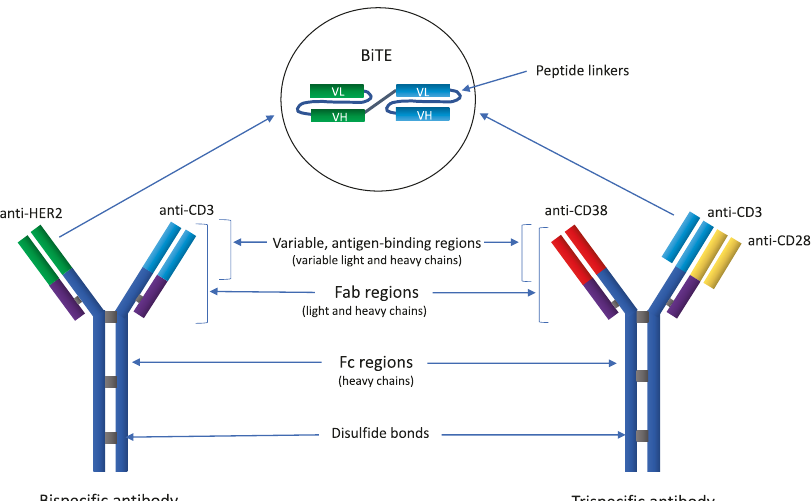
Fig. 5 Schematic examples of bi- and trispeci fi c antibodies and cell engager molecules. Bi- and tri-speci fi c antibodies are engineered molecules designed to simultaneously bind two or three different targets, respectively. They are recombinant proteins with variable Fab regions or fragments of light chains. Novel antibodies under current clinical investigation target either one or two T-cell receptors (e.g., CD3 and CD28) and a tumor-speci fi c (and stably expressed) antigen (e.g., CD19, CD38, HER2) with limited distribution in normal tissue to reduce off-target effects. CD3 binding induces T-cell stimulation and drives the T cell to the tumor cell. CD28 binding mediates co-stimulatory signals to fully activate the T cell receptor, reduce the release of non-speci fi c cytokines, and increase the expression of Bcl-xL that blocks T-cell apoptosis. When the antibody anchors the T cell to the tumor cell epitope, it forms a synapse that leads to cytotoxic cytokine release, target cell killing, and T-cell proliferation. Through serial lysis, individual T cells are able to induce multiple tumor cell killings. Bispeci fi c engager molecules: The variable antigen-binding regions of the heavy and light chains can be fused together to form a single-chain variable fragment (scFv), which is only half the size of the Fab fragment but still retains the speci fi city of the parent antibody. These molecules are recombinant, scFv fusion protein constructs comprised of the antigen-binding regions (variable heavy and light chains) of two antibodies bound together by linker peptides (usually Ser-Gly peptide linkers). An engager molecule binds with e.g., CD3 on T cells (bispeci fi c T cell engager — a BiTE) or CD16 on NK cells (bispeci fi c killer-cell engager — a BiKE). The other arm binds to a tumor-associated antigen (e.g., HER2). Tri- and tetra-speci fi c killer-cell engagers (TriKEs and TetraKEs) have been designed and are currently under clinical evaluation. Fab region the fragment antigen- binding region that binds to antigens is composed of one constant and one variable domain of each of the heavy and the light chain. FC region the fragment crystallizable region is the tail region of the antibody that interacts with cell surface Fc receptors. VL variable light chain, VH variable heavy